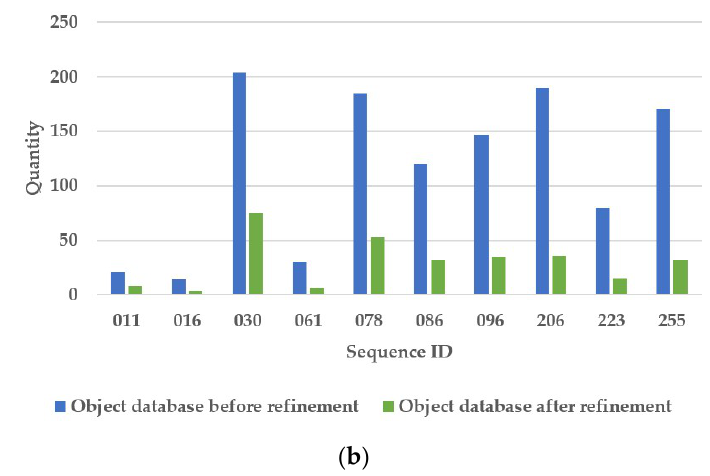
Figure 8. Comparison of the number of database objects before and after refinement processing on the SceneNN dataset: ( a ) 3D object detection column chart; and ( b ) object database column chart.